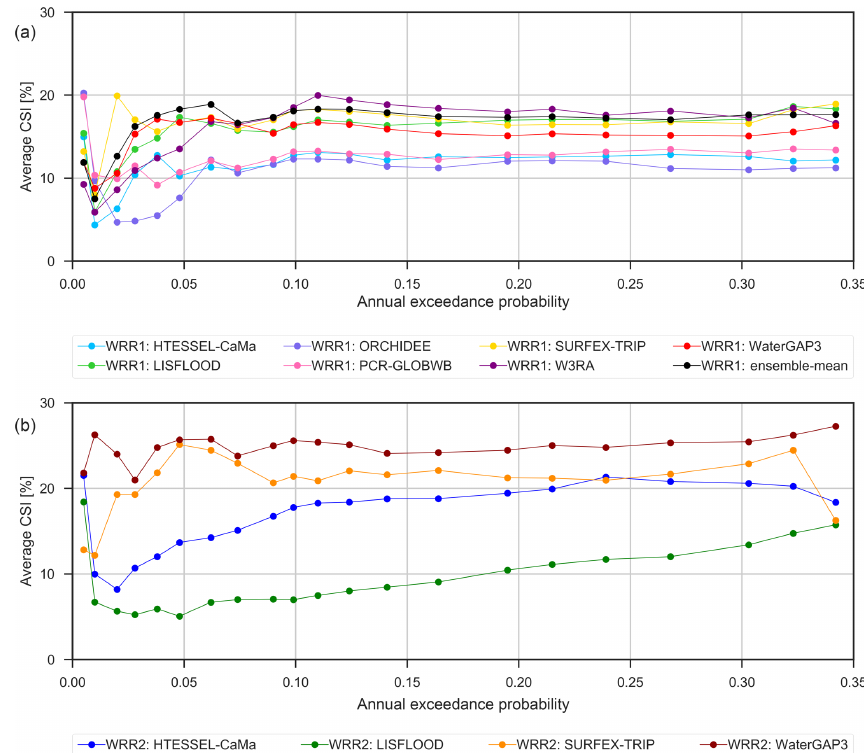
Figure 4. The critical success index (CSI) using different annual exceedance probability thresholds averaged over all gauging stations for the seven models and ensemble mean available in WRR1 (a) , and the four models that are also available in WRR2 (b)